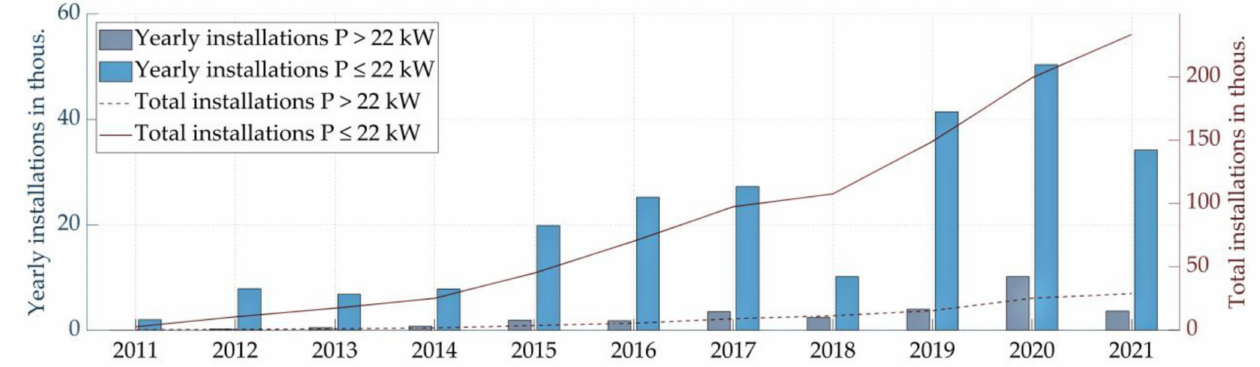
Figure 1. Development of public charging stations in Europe